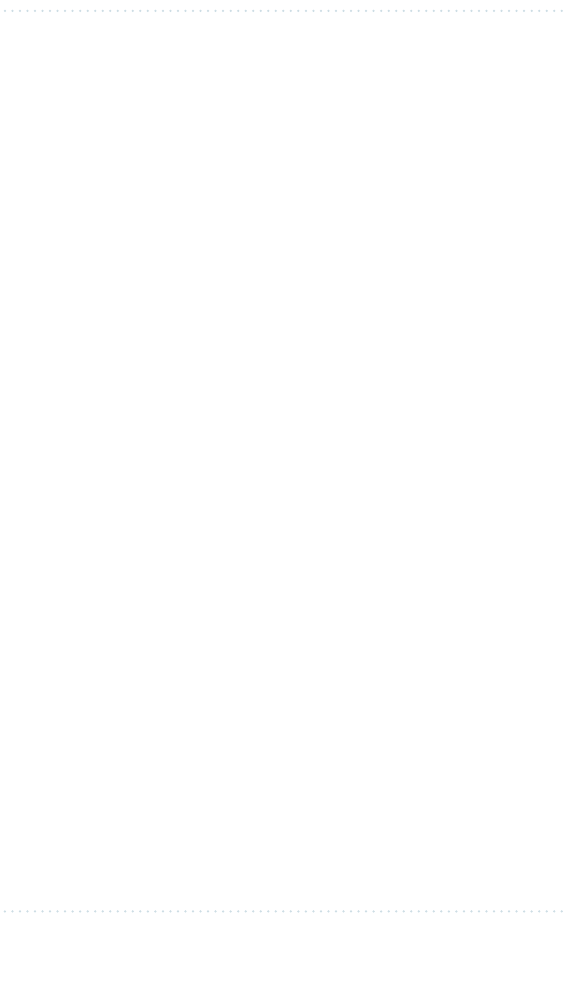
Table 3. Friction test parameters.